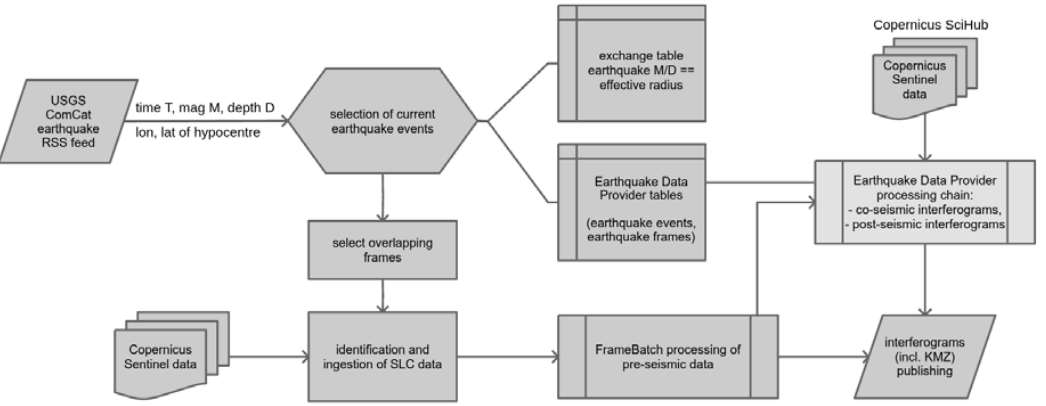
Figure 6. LiCSAR Earthquake Interferometric Synthetic Aperture Radar (InSAR) Data Provider processing flowchart. The system leads to the generation of co-seismic and post-seismic interferograms initiated by ingesting information about current earthquakes from the United States Geological Survey (USGS) ComCat service. Table 1. Earthquake response threshold criteria for the Earthquake InSAR Data Provider (EIDP), based upon empirical scaling of fault dimensions with magnitude and anticipated wavelength of measurable surface displacement of a buried elastic source. The postseismic interval indicates the length of time the near-real time processing by EIDP is undertaken, prior to return to their regular processing. Max. Depth of Surface E ff ect Radius Postseismic InSAR [Days Magnitude [ M w ] Hypocentre [km] from Epicentre [km] after Earthquake